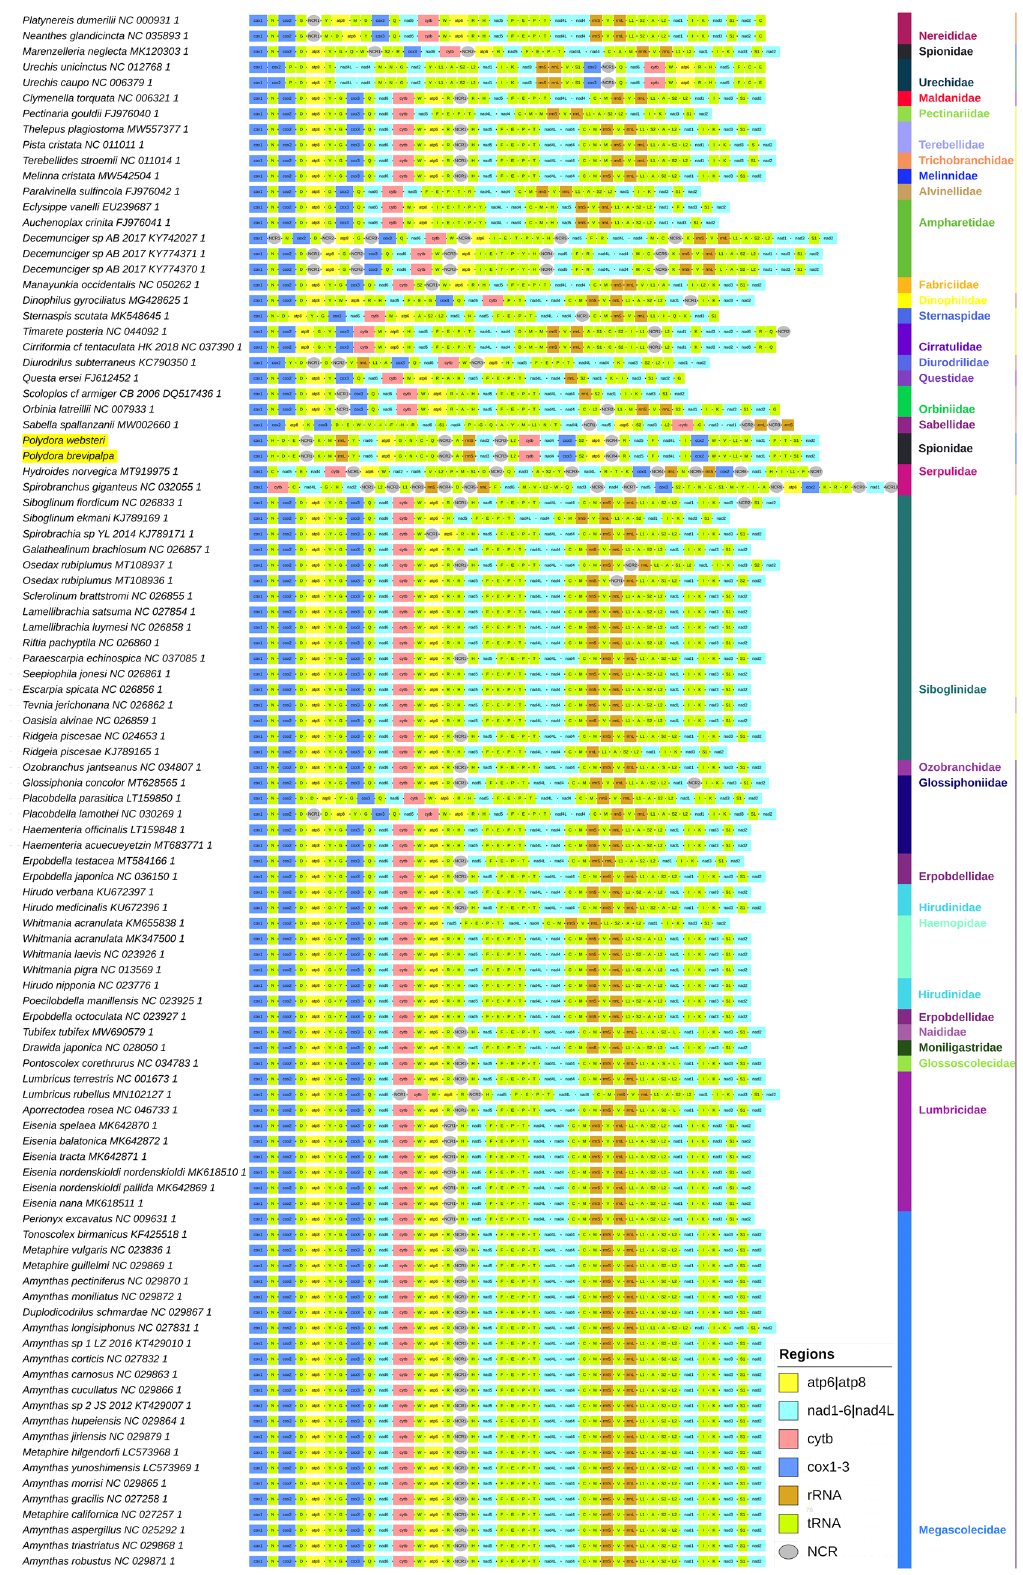
Figure 1. Mitochondrial architecture in the studied annelid dataset. GenBank numbers of sequences are shown next to species’ names. The two newly sequenced Polydora species are highlighted by the yellow background. Taxonomic identity is shown to the right at the family level. The colour legend for mitogenomic architecture is shown in the